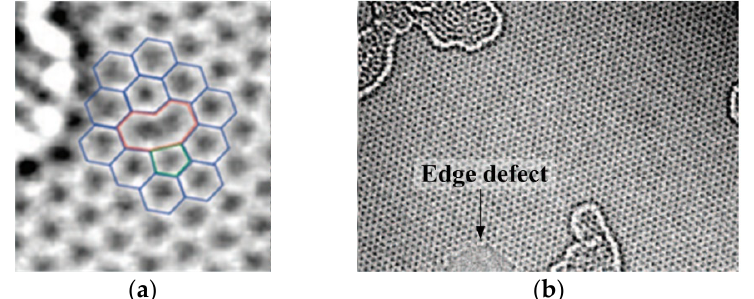
Figure 1. Experimental transmission electron microscope (TEM) image of ( a ) a single vacancy defect; and ( b ) an edge defect. Reproduced with permission from [24], © American Chemical Society, 2008.